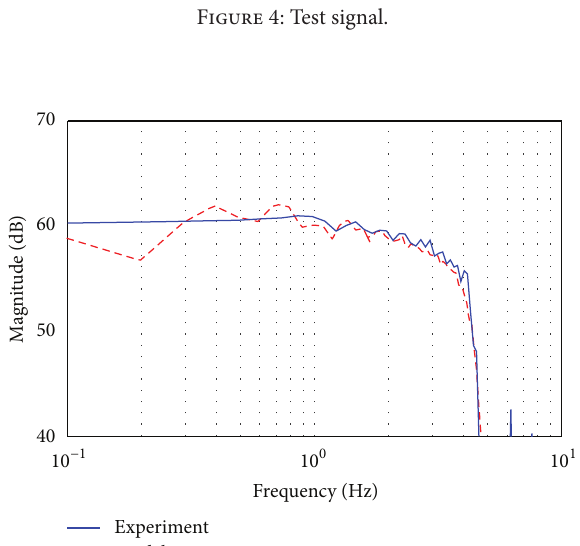
Figure 4: Test signal.